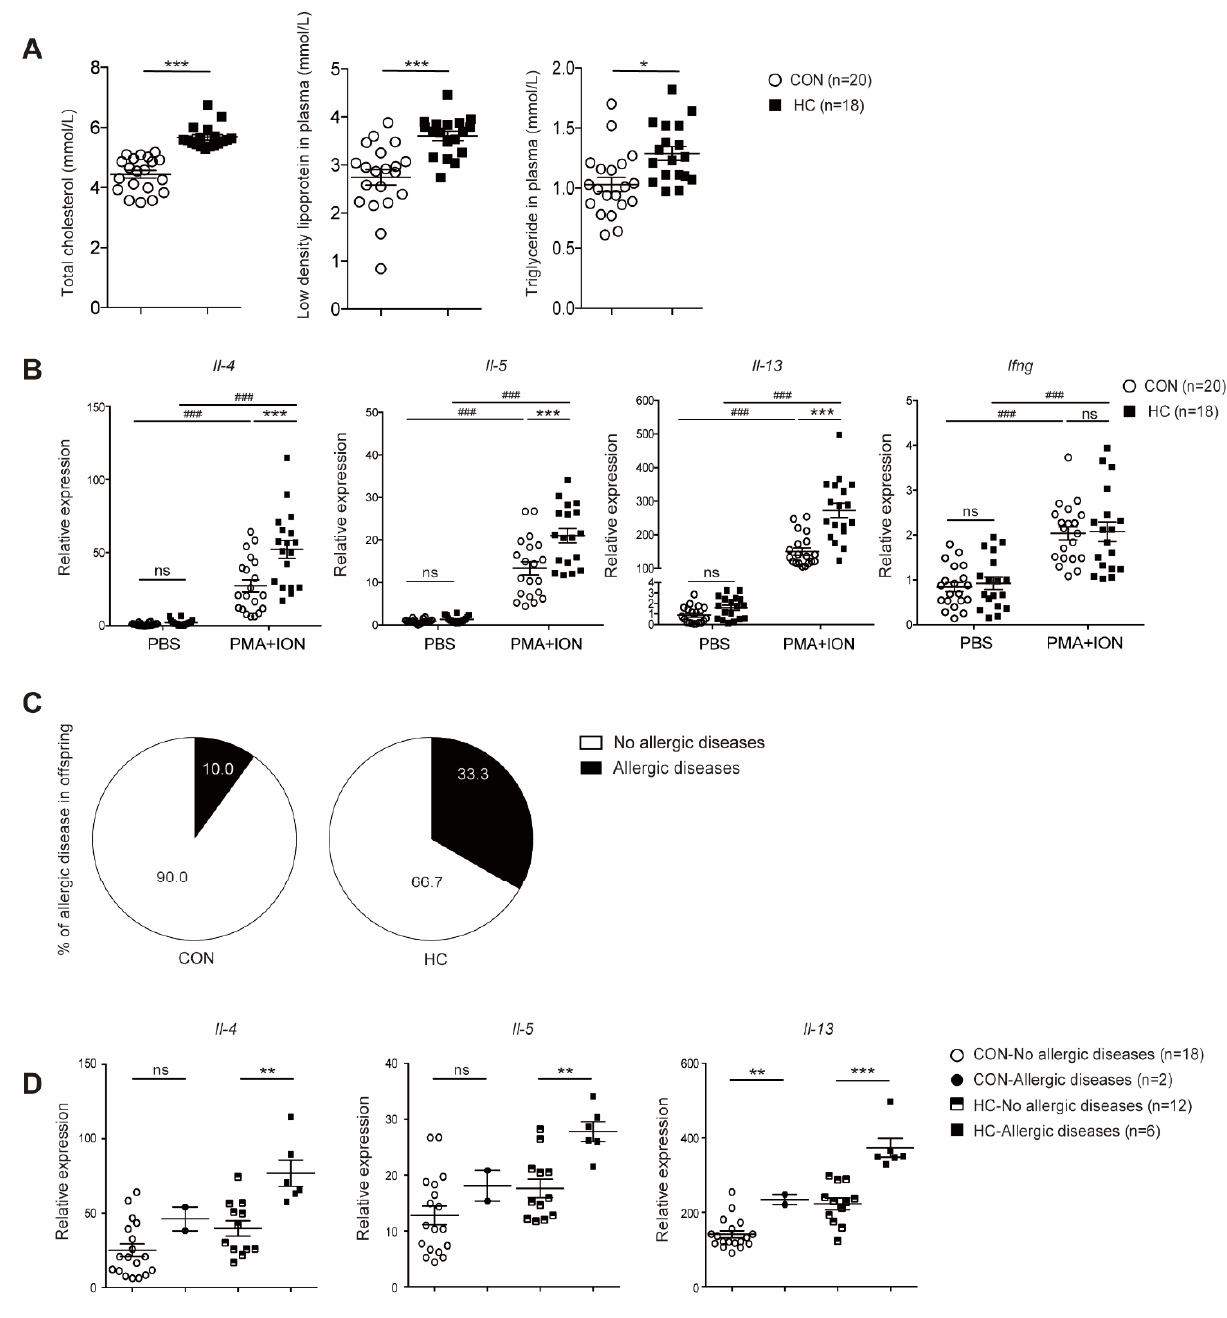
Figure 5. Neonates of hypercholesterolemic mothers expressed elevated levels of T H 2 cytokines and were prone to allergic diseases. Umbilical cord blood samples from neonates of hypercholesterolemic mothers (HC, n = 18) and control mothers (CON, n = 20) were collected. CD4 + T-cells were obtained by magnetic sorting. ( A ) Total cholesterol, triglyceride, and low-density lipoprotein concentration in maternal plasma on 12 gestational weeks. ( B ) Il-4 , Il-5 , Il-13 , and Ifng mRNA expression levels in cord blood CD4 + T-cells stimulated with PMA (50 ng/mL) and ionomycin (500 ng/mL) for 3 h. Participants were followed up for 3 years ( C , D ). ( C ) Percentage of parental reports of physician- diagnosed allergic diseases in offspring. ( D ) Relation of T H 2 cytokine mRNA expression levels in stimulated cord blood CD4 + T-cells and onset of allergic diseases in childhood. p values were deter- mined by a one-way ANOVA with Tukey multiple comparisons p value correction ( B ) or a Student’s t -test ( A , D ). Data are shown as means ± SEM. n , Number of participants in each group. * p < 0.05, ** p < 0.01, *** p < 0.001, CON versus HC. ### p < 0.001, PMA and ionomycin versus PBS. ns , not signif- icant.